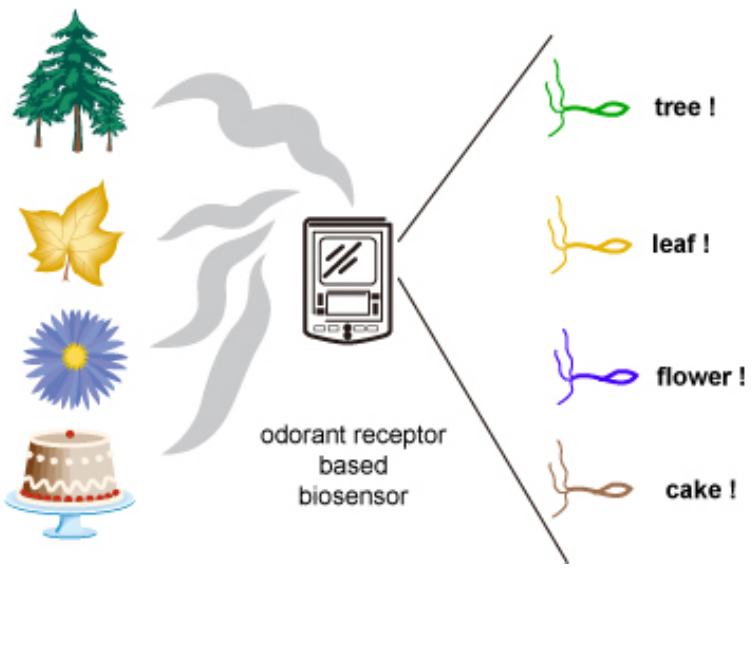
Figure 7. Odorant receptor based